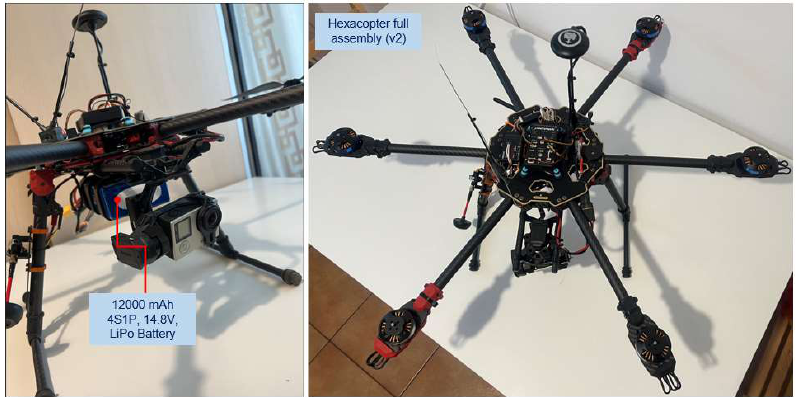
Figure 5. Hexacopter assembly for variant v2.